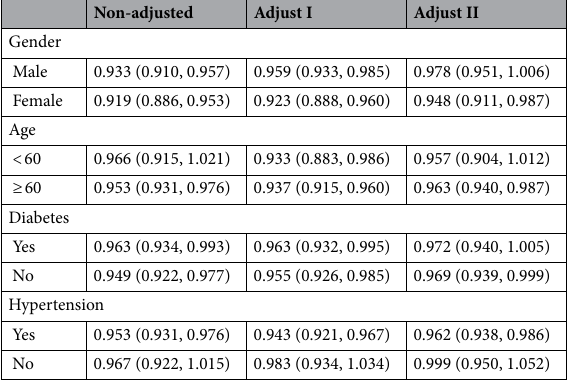
Table 3. subgroup analysis. Non-adjusted model adjust for: None. Adjust I model adjust for: Gender; Age; Race. Adjust II model adjust for: Gender; Age; Race; Diabetes; HDL-C; Hypertension; LDL-C; Creatinine. When gender, age, diabetes or hypertension is the hierarchical variable, it is not adjusted.